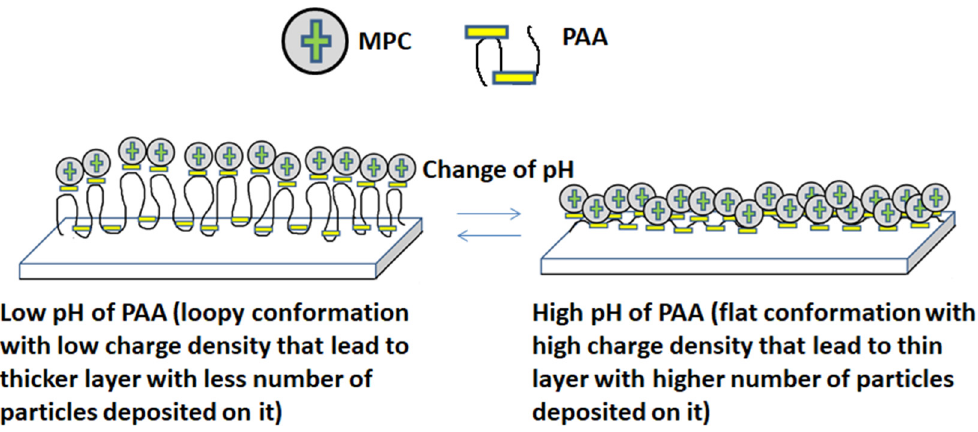
Figure 9. A schematic illustration of the behavior of PAA at low and high pH and sequential adsorption of magnetic polymer colloids (MPC).